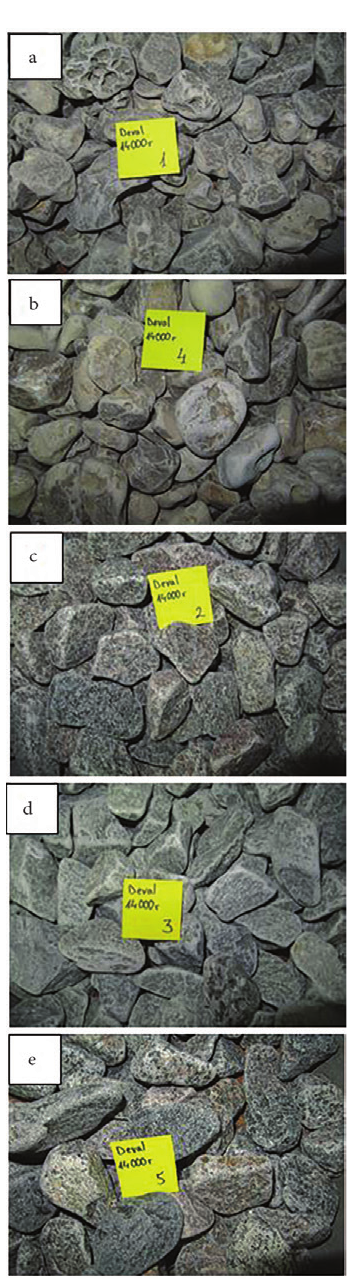
Fig. 1. The dried samples after the Los Angeles Abrasion test (Figure parts a, b, c, d, e provide the D1, D2, G1, G2, G3 mixtures)